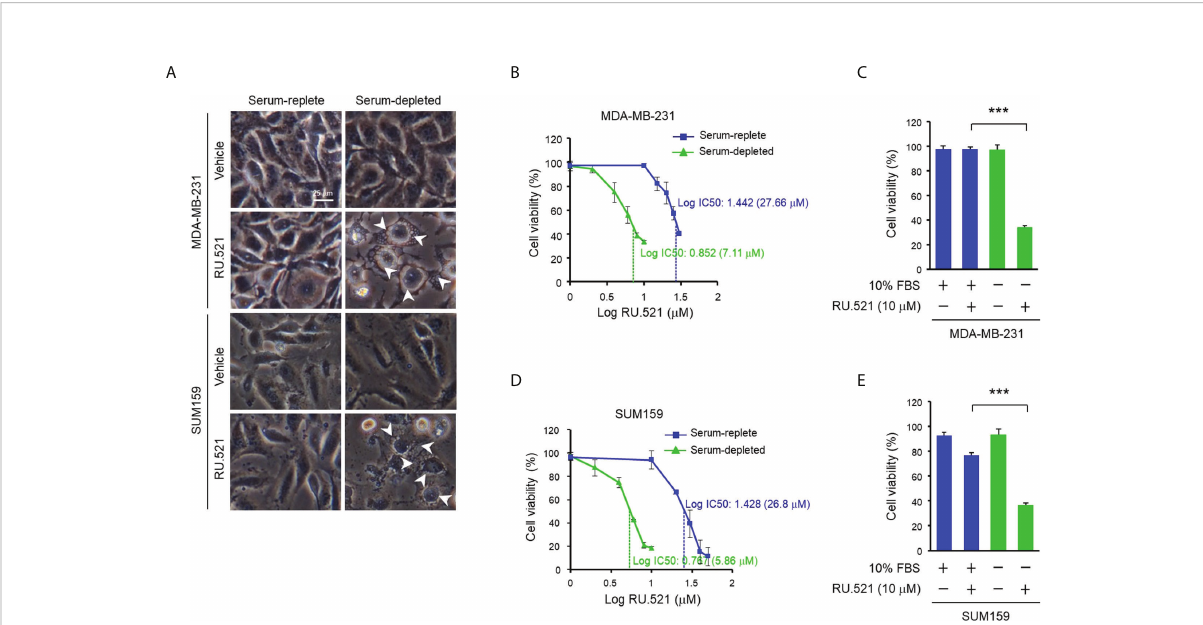
FIGURE 3 Treatment with RU.521 abrogated viability of TNBC cells cultured in serum-depleted media. (A) , MDA-MB-231 and SUM159 cells were cultured in normal growth media containing 10% FBS or serum-depleted media for 48 hr. Bright fi eld images were taken at 400x magni fi cation. White arrowheads indicate the cytoplasmic vacuoles. Bar, 25 m m. (B – E) MDA-MB-231 (B, C) and SUM159 (D, E) cells cultured in normal growth media containing 10% FBS (blue) or serum-depleted media (green) treated with different doses (B, D) and at the dose of 10 m M (C, E) of RU.521 for 48 hr. Cell viability was determined by crystal violet staining and detected by absorbance at 595 nm. The results of three independent experiments are shown as means ± SD. Statistical signi fi cance was calculated by Student ’ s t-test. ***, p < 0.001. The half maximal inhibitory concentration (IC 50 ) of RU.521 for each cell line is